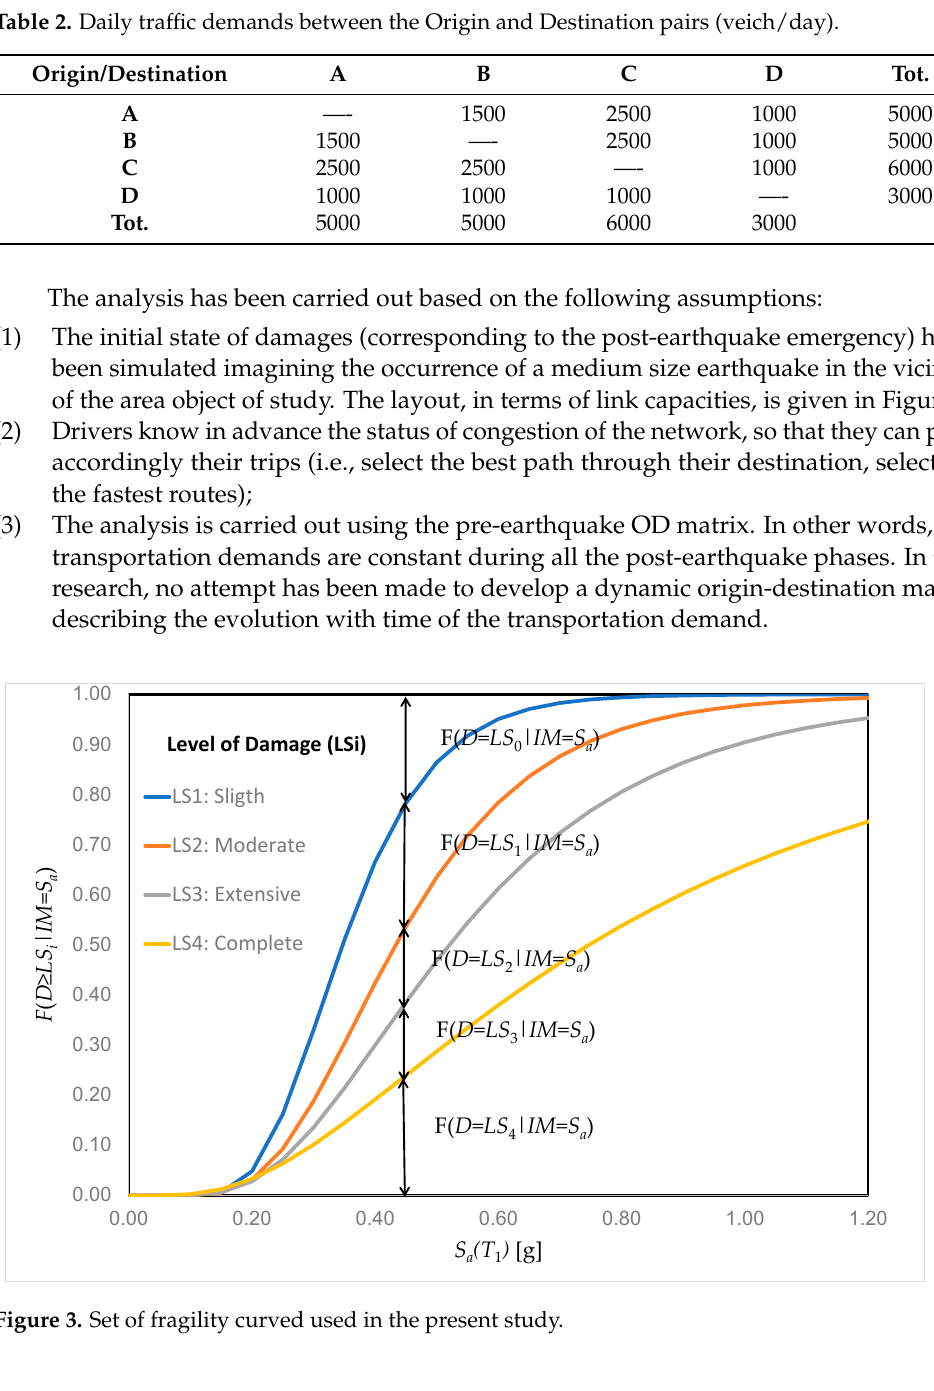
Table 2. Daily traffic demands between the Origin and Destination pairs (veich/day). Origin/Destination A B C D Tot.